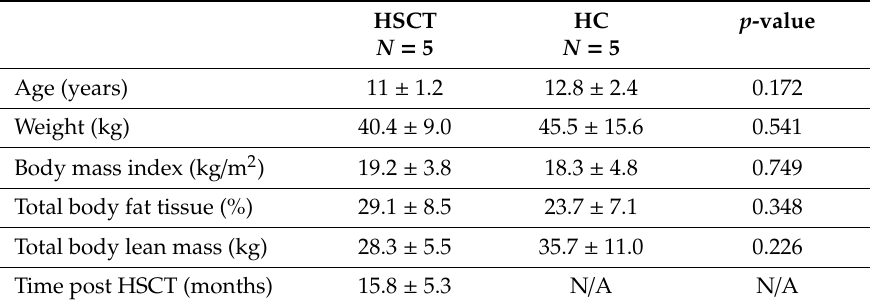
Table 1. Demographic characteristics.